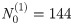
Two-species biofilm growth simulations with N0(1)=144 and N0(2)=261.Mean of 50 simulations of the mean thickness at 3h, 24h and 48h with respect to the concentration of nutrients cs0(i)/p for different values of p: (a) Model 1 for P. gingivalis and S. gordonii independent, (b) Model 2 for P. gingivalis and S. gordonii in competition for proteins, (c) Model 3 for P. gingivalis and S. gordonii with production of toxic substance. (d) P. gingivalis percentage in biofilms for the 3 models.